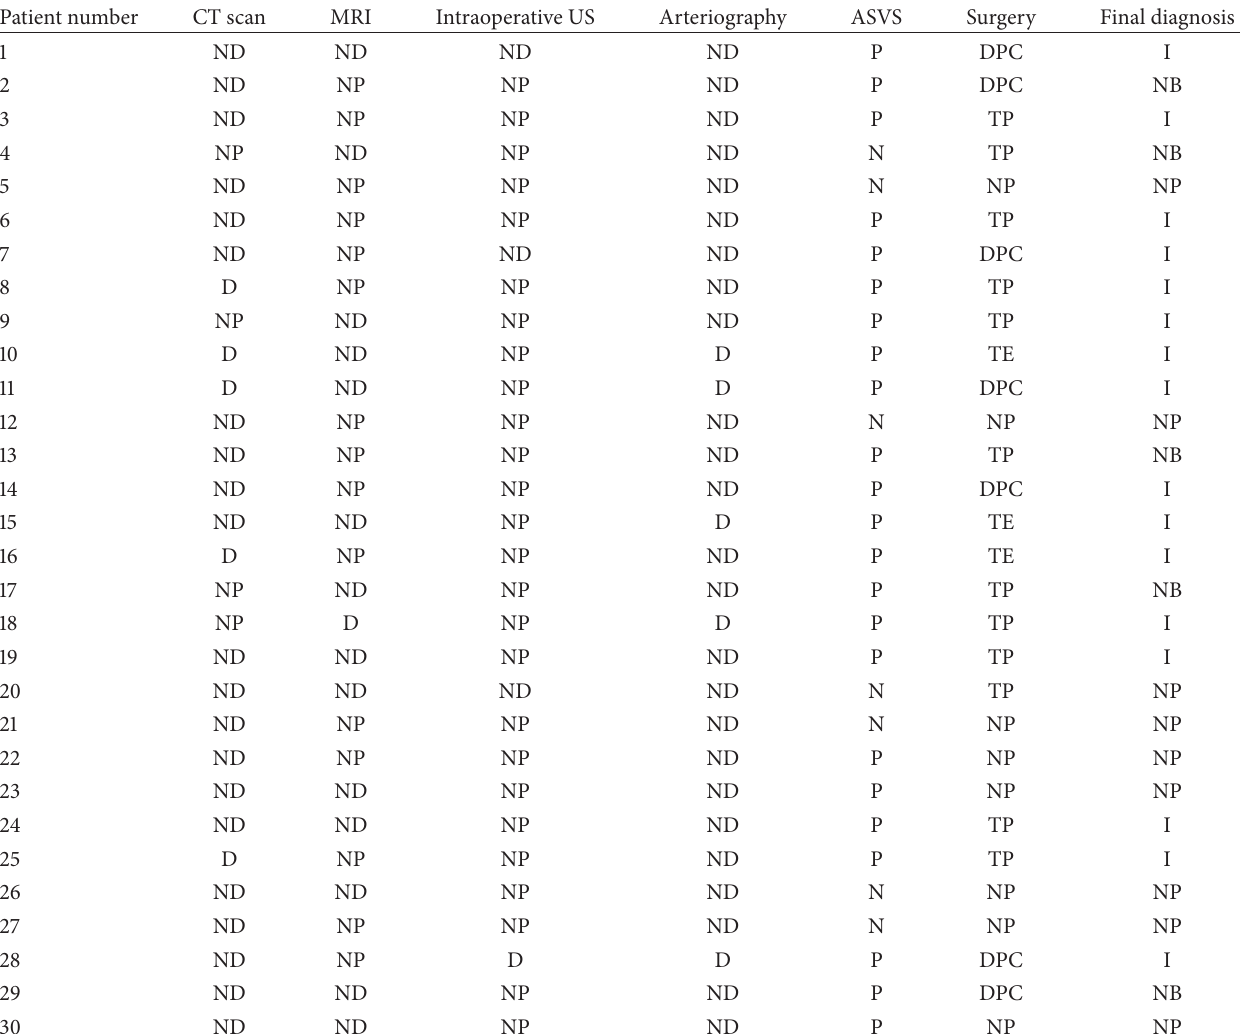
Table 1: Patients and diagnosis tests for the detection of insulinoma.